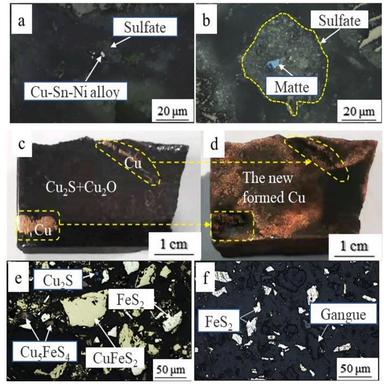
Characteristics of Cu phases: (a–f) Optical microscope images of (a) Cu-sn-Ni alloy in leach residue; (b) matte in leach residue; (c) block matte in in situ experiment; (d) leaching sample in in situ experiment; (e) lead-free copper concentrate; and (f) leach residue of copper concentrate.